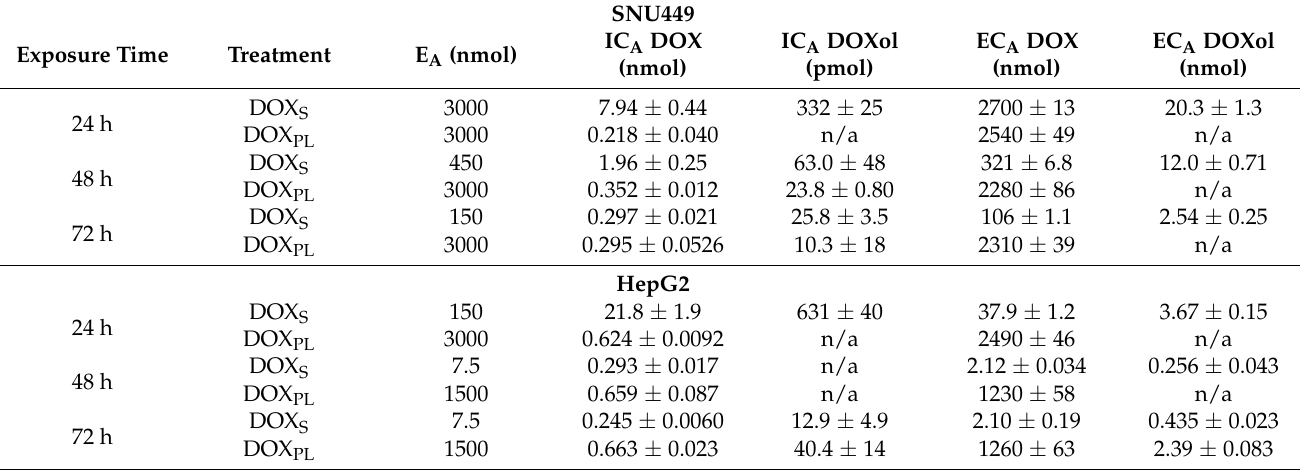
shown. Cell lines were treated with extracellular concentrations of DOX S or DOX PL corre- sponding to their calculated IC 50 values (Table 2). The maximum concentration of DOX S or DOX PL used was 200 µ M. The relationship between intracellularly and extracellularly quantified DOX and DOXol is demonstrated in Figures 3 and 4, respectively. The measured median diameter of the cells was 14 µ m for SNU449, Huh7, MCF7, and 12 µ m for HepG2. The number of tumor cells left after the end of the drug exposure period for each tested cell line is given in Table 3. Table 2. The calculated amounts (mean ± SD) intracellular DOX (IC A DOX) and DOXol (IC A DOXol), as well as the extracellular DOX (EC A DOX) and DOXol (EC A DOXol) of each exposure amount (E A ). When the quantified amount was below the LLOQ, it is symbolized with “n/a”. Each E A was based on the calculated IC 50 of that treatment with a maximum E A of 3000 nmol. Please note that IC A DOXol is reported in pmol, while the other amounts are reported in